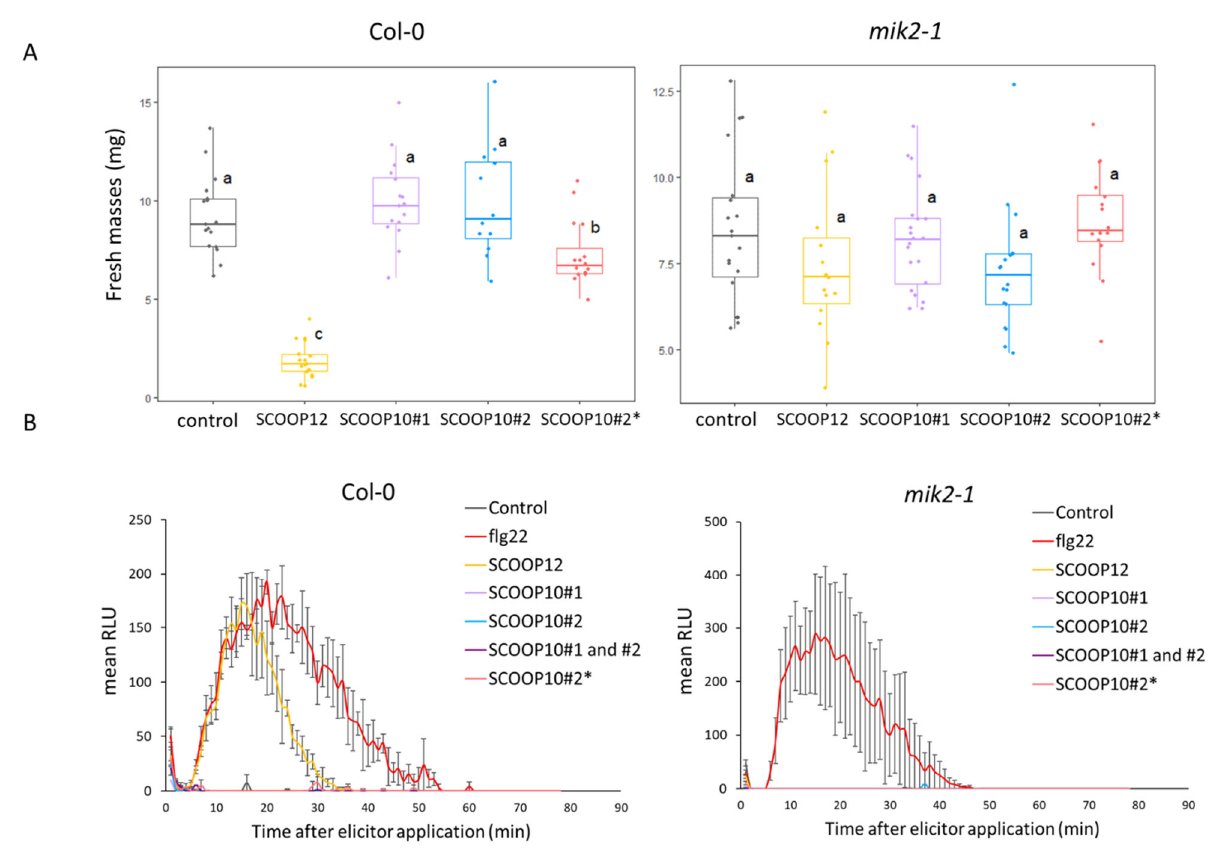
Figure 4. Effects of SCOOP10 peptides on seedling growth and on ROS production. ( A ) Seedling growth inhibition evaluation by measuring fresh mass after 1 µ M elicitor or control treatment. ( B ) H 2 O 2 production after 1 µ M elicitor or control treatment measured with a luminol-based assay using leaf discs from four-week-old plants of the indicated genotypes. Data represented are means of three independent replicates in relative luminescence units (RLUs) ( n = 3, ± SEM). For ( A , B ), SCOOP10#1 and SCOOP10#2 correspond to the proline hydroxylated peptides, and prolines are not hydroxylated for the SCOOP10#2*peptide. ANOVA and Tukey test results allow us to define significantly different groups, labelled from a to c, at the p < 0.05